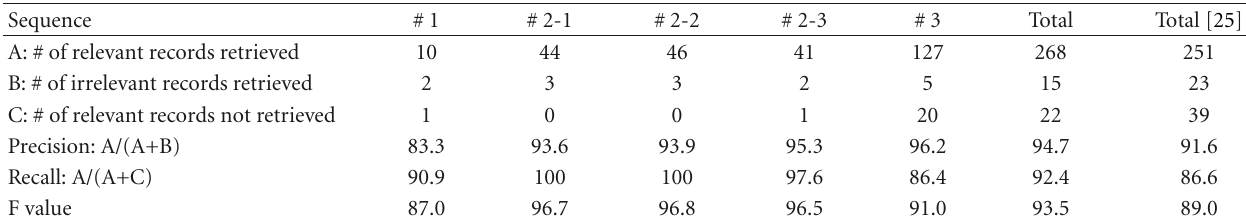
Table 2: Performance summarization of motion segmentation. Results in [25] are also shown for